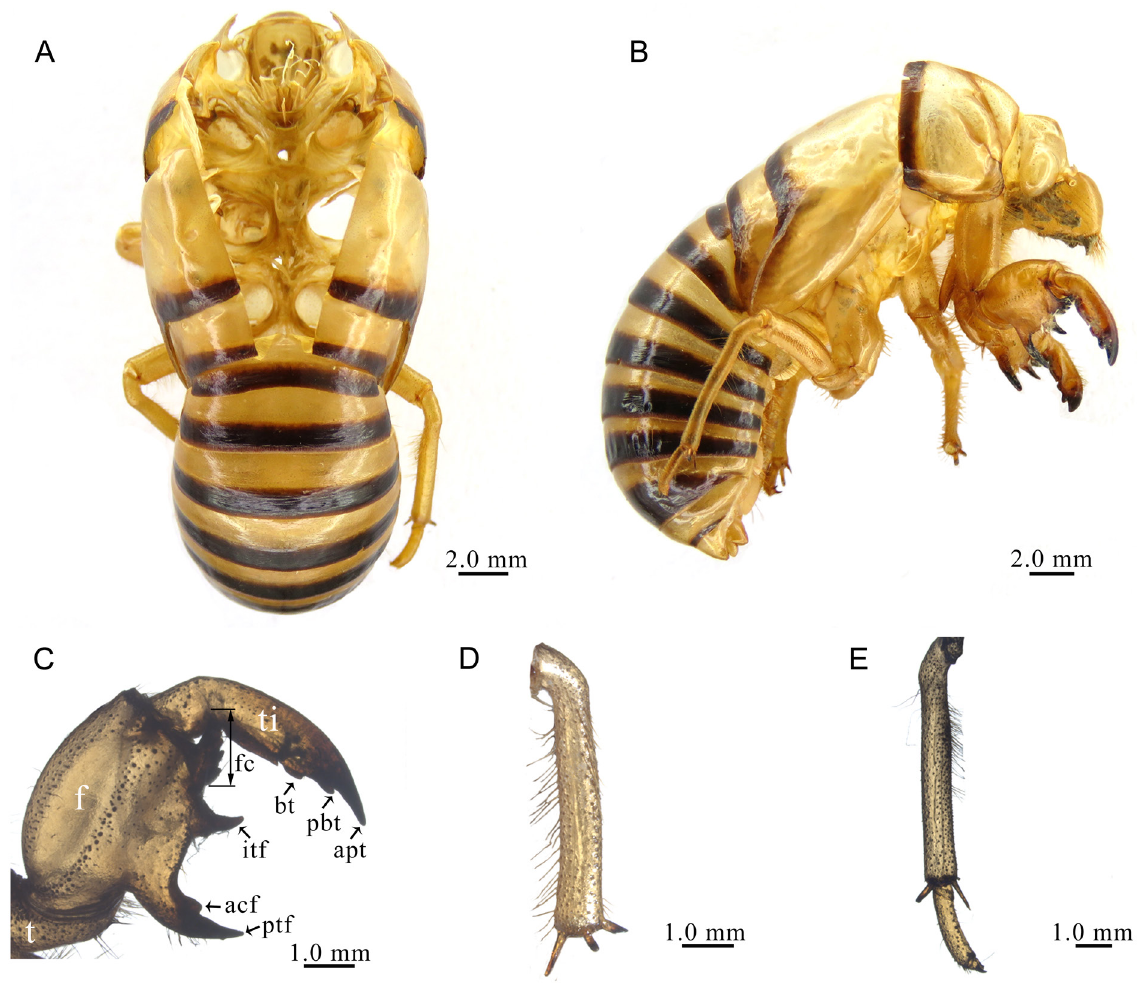
Fig. 2. Paharia oorschoti sp. nov. (♂, exuvia, holotype). A . Dorsal view of body. B . Lateral view of body. C . Right fore leg, outer view. D . Spines at the apex of mid tibia. E . Spines at the apex of hind tibia. Abbreviations: acf = accessory tooth of femur; apt = apical tooth of tibia; bt = blade of tibia; f = femur; fc = femoral comb; itf = intermediate tooth of femur; pbt = point of blade of tibia; ptf = posterior tooth of femur; t = trochanter; ti =